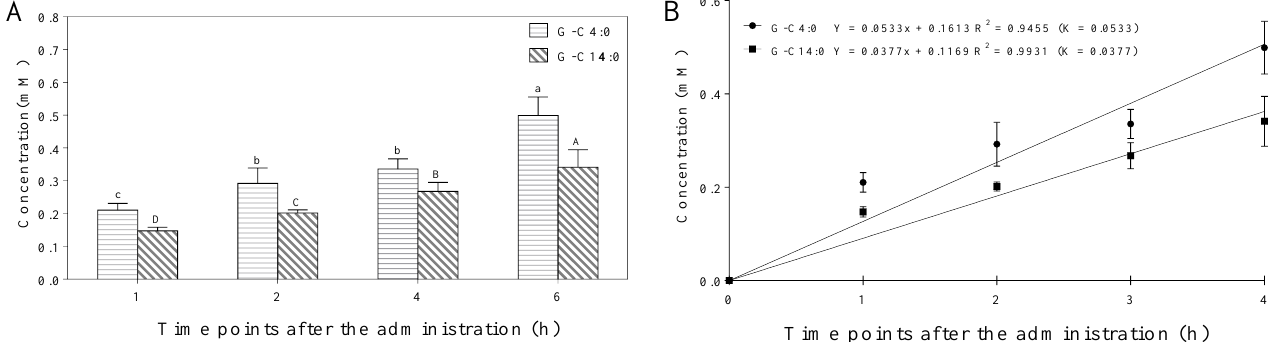
Figure 3. Concentrations ( A ) and kinetic models ( B ) of GA liberated from the hydrolysis of G-C4:0 and G-C14:0 in the contents of small intestine. Bars with different letters (A – D, a – c) are statistically different ( p < 0.05).